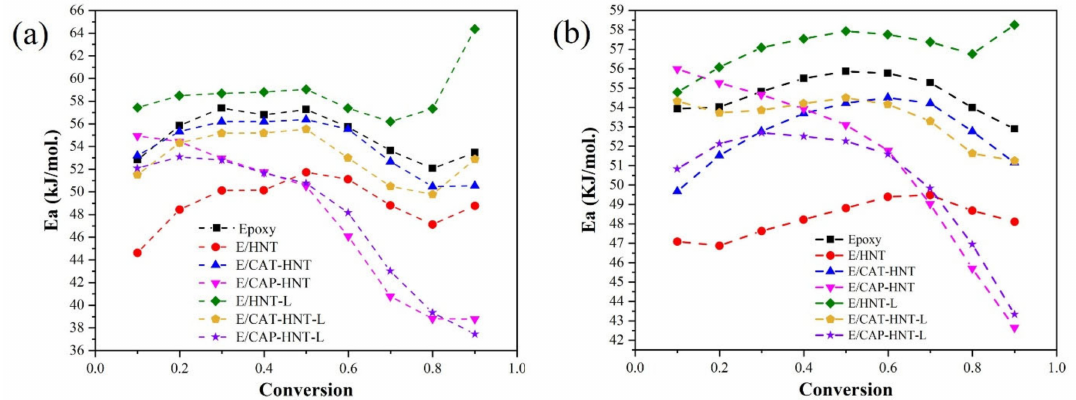
Figure 11. Estimation of the apparent activation energy for the neat epoxy and epoxy/HNT nanocomposites: ( a ) differential Friedman and ( b ) integral Kissinger-Akahira-Sunose (KAS)